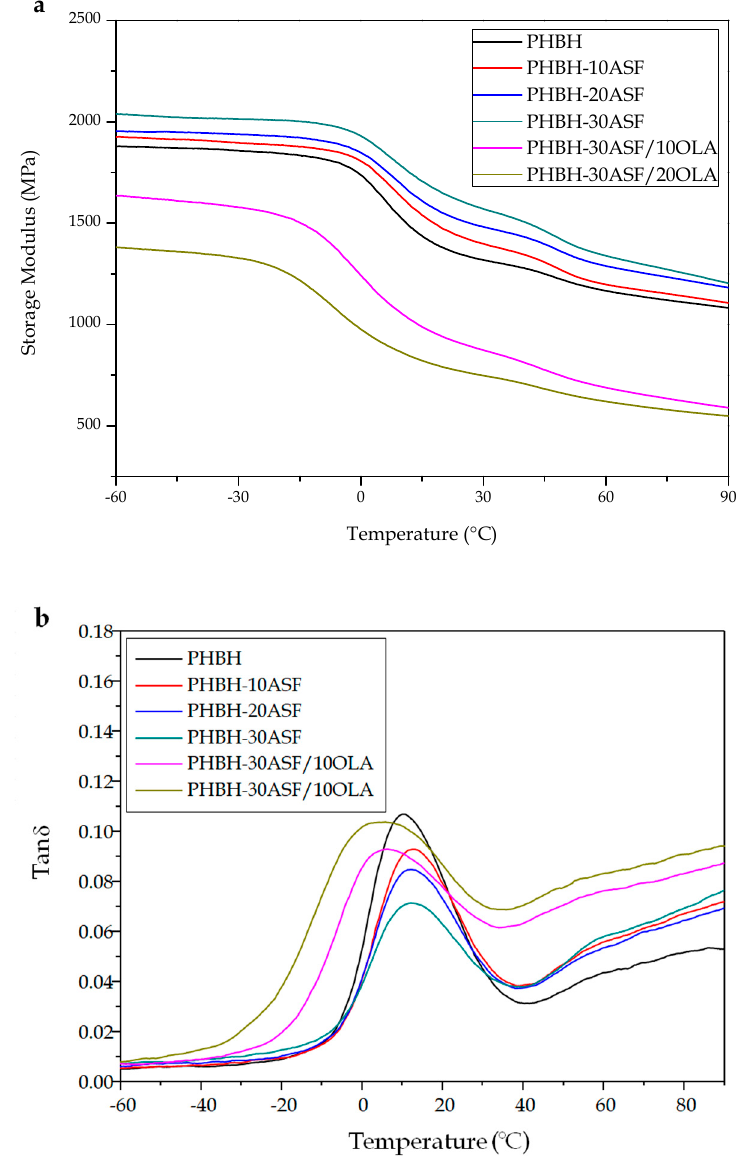
Figure 5. Comparative plot of dynamic-mechanical thermal analysis (DMTA) curves of PHBH-ASF / OLA composites with di ff erent compositions: ( a ) flexural storage modulus ( E’ ) and ( b ) dynamic damping factor ( tan δ ).